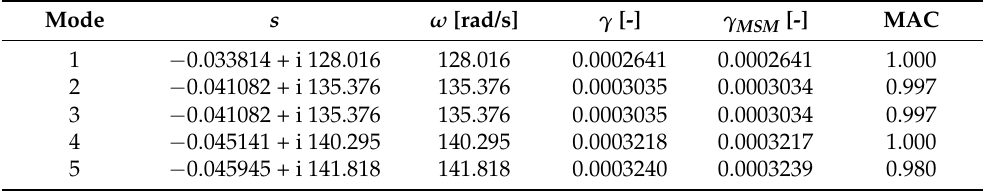
Table 4. Dome 3—NEP eigenvalues, natural frequency, non-dimensional damping ratio and MAC.